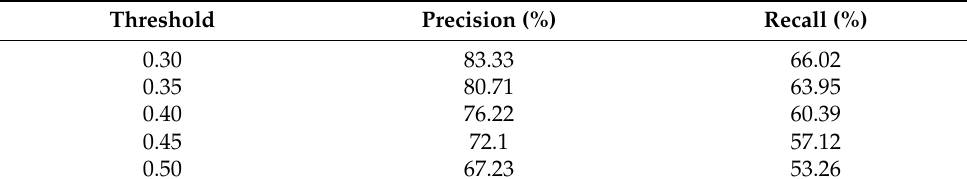
Table 5. Object-level performance metrices after applying the post-processing method.